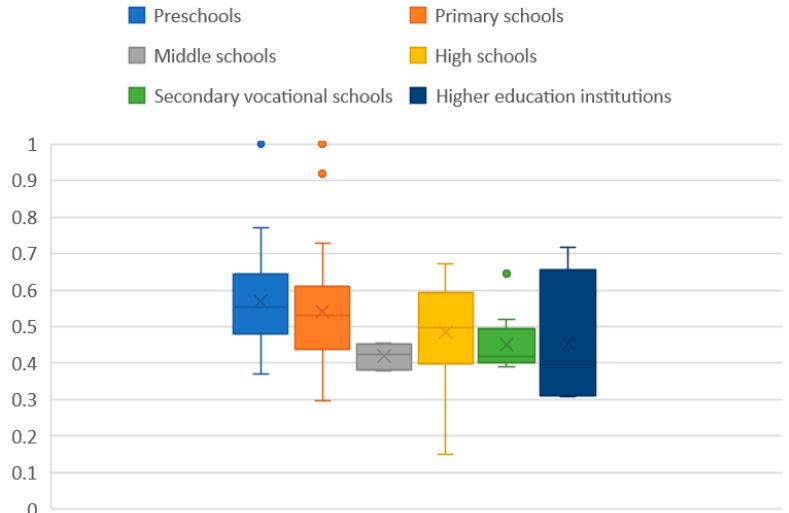
Figure 6. Box plot for comprehensive urban land accessibility of the locations of educational facilities at all levels in a typical county.